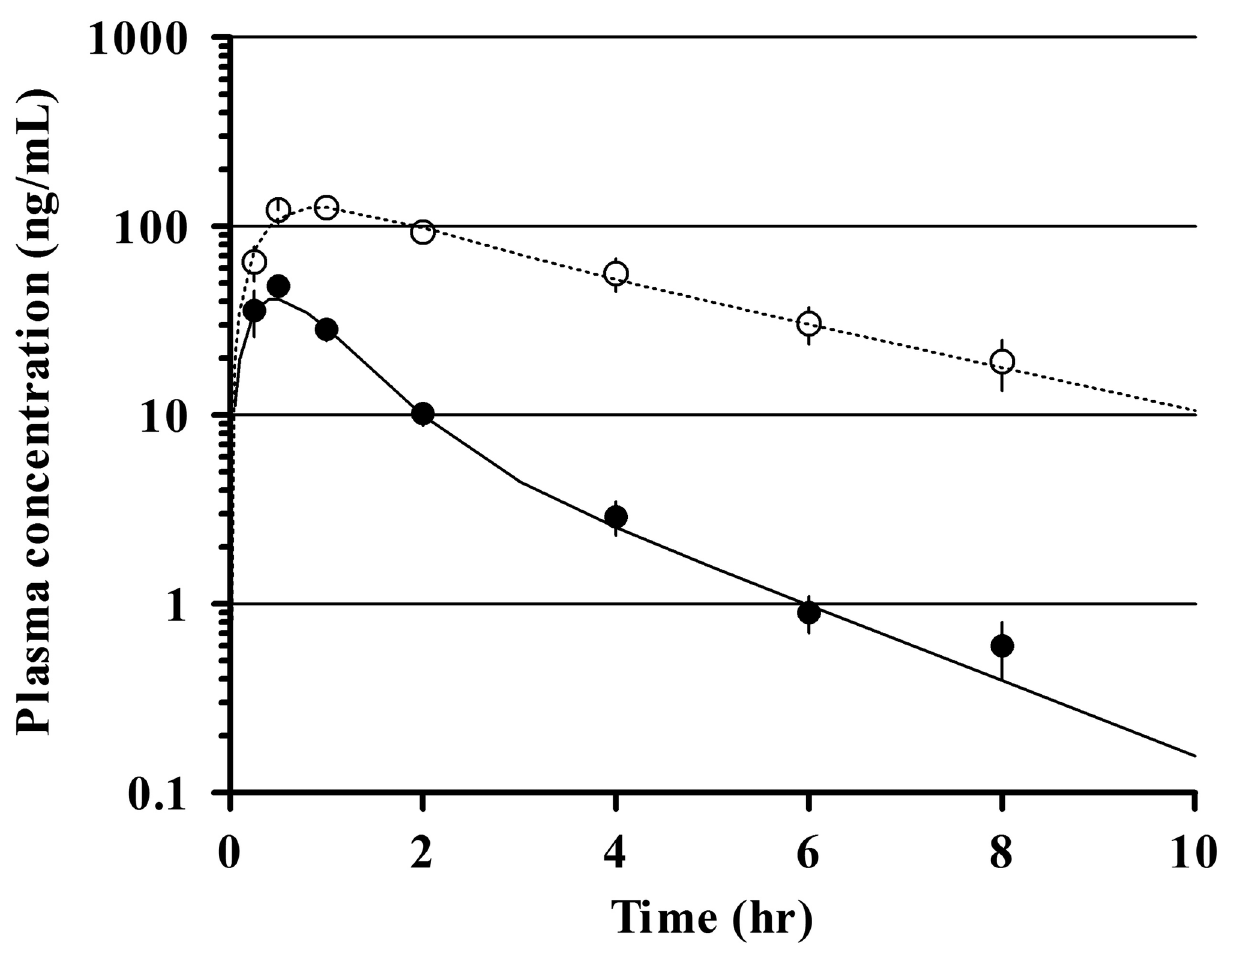
Figure 6. Plasma PK profile of E2110 after oral administration to rats. Symbols denote observed plasma concentrations (mean±S.E.M, n = 4/time point) in male (●) and female SD rats (○). Lines represent fitting of a two-compartment PK model with first- order absorption to the experimental